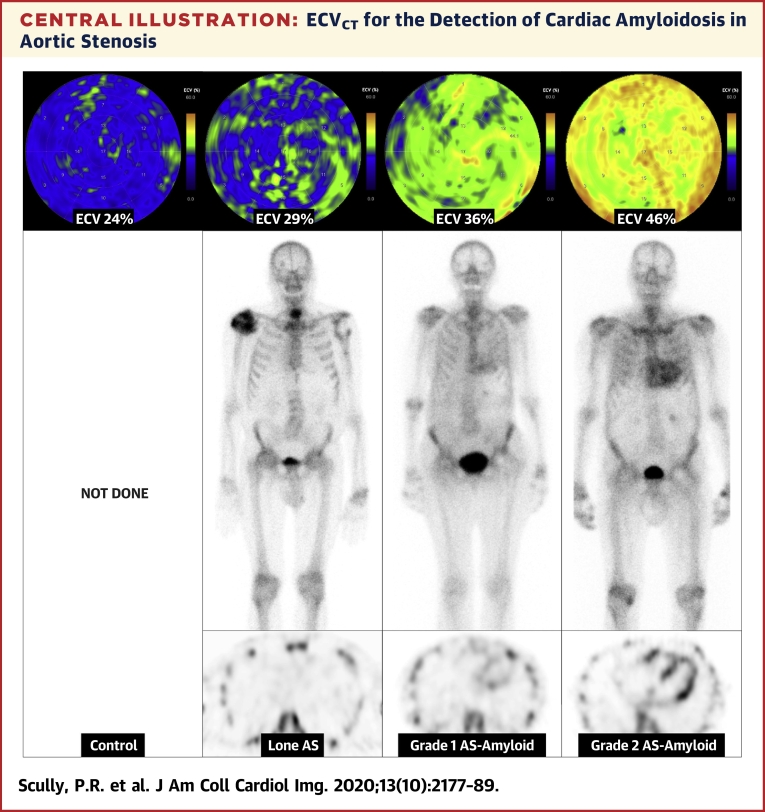
ECVCT for the Detection of Cardiac Amyloidosis in Aortic StenosisExtracellular volume (ECV) quantification by computed tomography (ECVCT) polar maps (top), 99mTc-3,3-diphosphono-1,2-propanodicarboxylic acid (DPD) planar (middle), and axial single-photon emission computed tomography images (bottom) from control (far left) through lone aortic stenosis (AS), DPD Perugini grade 1, and DPD Perugini grade 2 (far right).